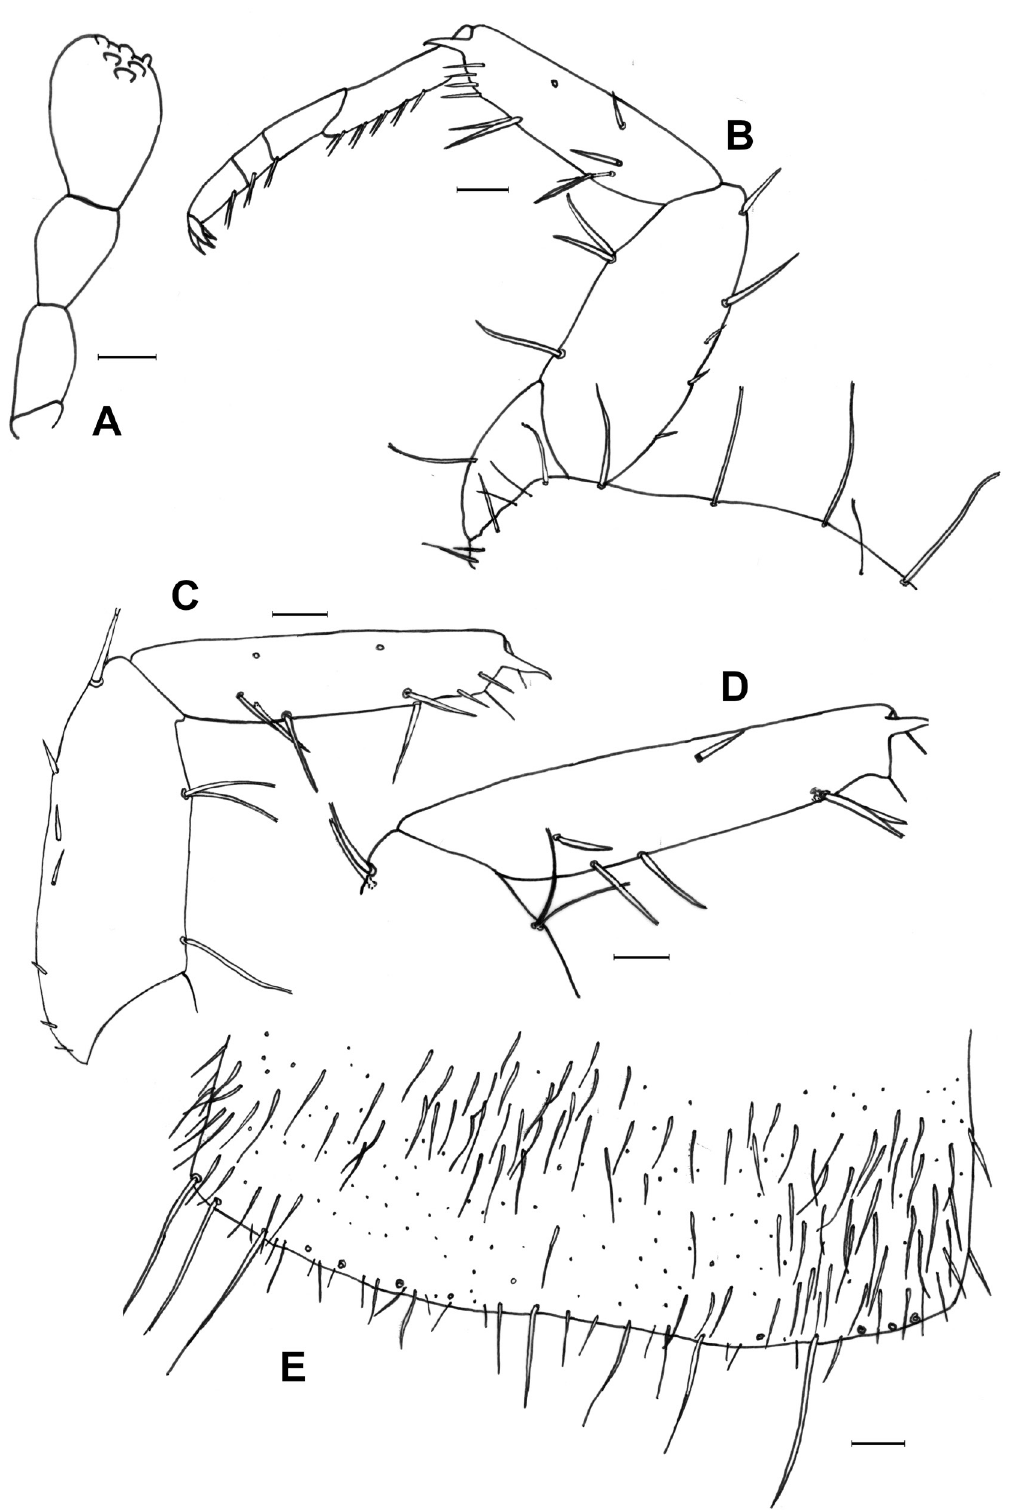
Fig. 10. Coletinia serrata Mendes, Molero-Baltanás, Bach de Roca & Gaju-Ricart sp. nov. Holotype, ♂ (MUHNAC, CZ-5646). A . Labial palp. B . First leg, except coxa. C . Femur and tibia of the second leg. D . Metatibia. E . Urotergite II. Scale bars = 0.1